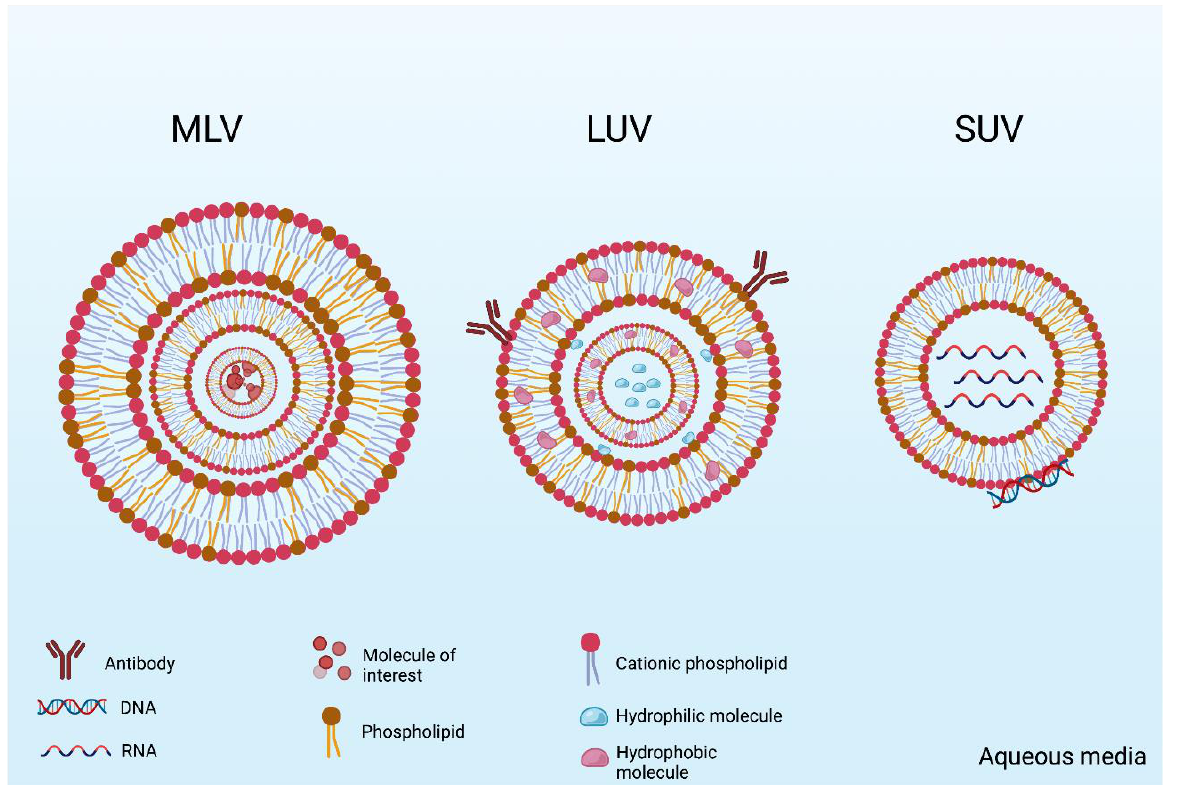
Figure 1. A schematic representation of the different types of liposomes: multilamellar vesicles (MLVs), large unilamellar vesicles (LUVs), and small unilamellar vesicles (SUVs). The vesicles can be decorated with surface molecules such as antibodies and can encapsulate both hydrophilic and hydrophobic molecules. Nucleic acids usually are entrapped when the liposome phospholipids have cationic charges. For nucleotide liposomes, the DNA or RNA molecule can be entrapped in the inner aqueous space or be absorbed on the vesicle surface due to the cationic phospholipids charges.